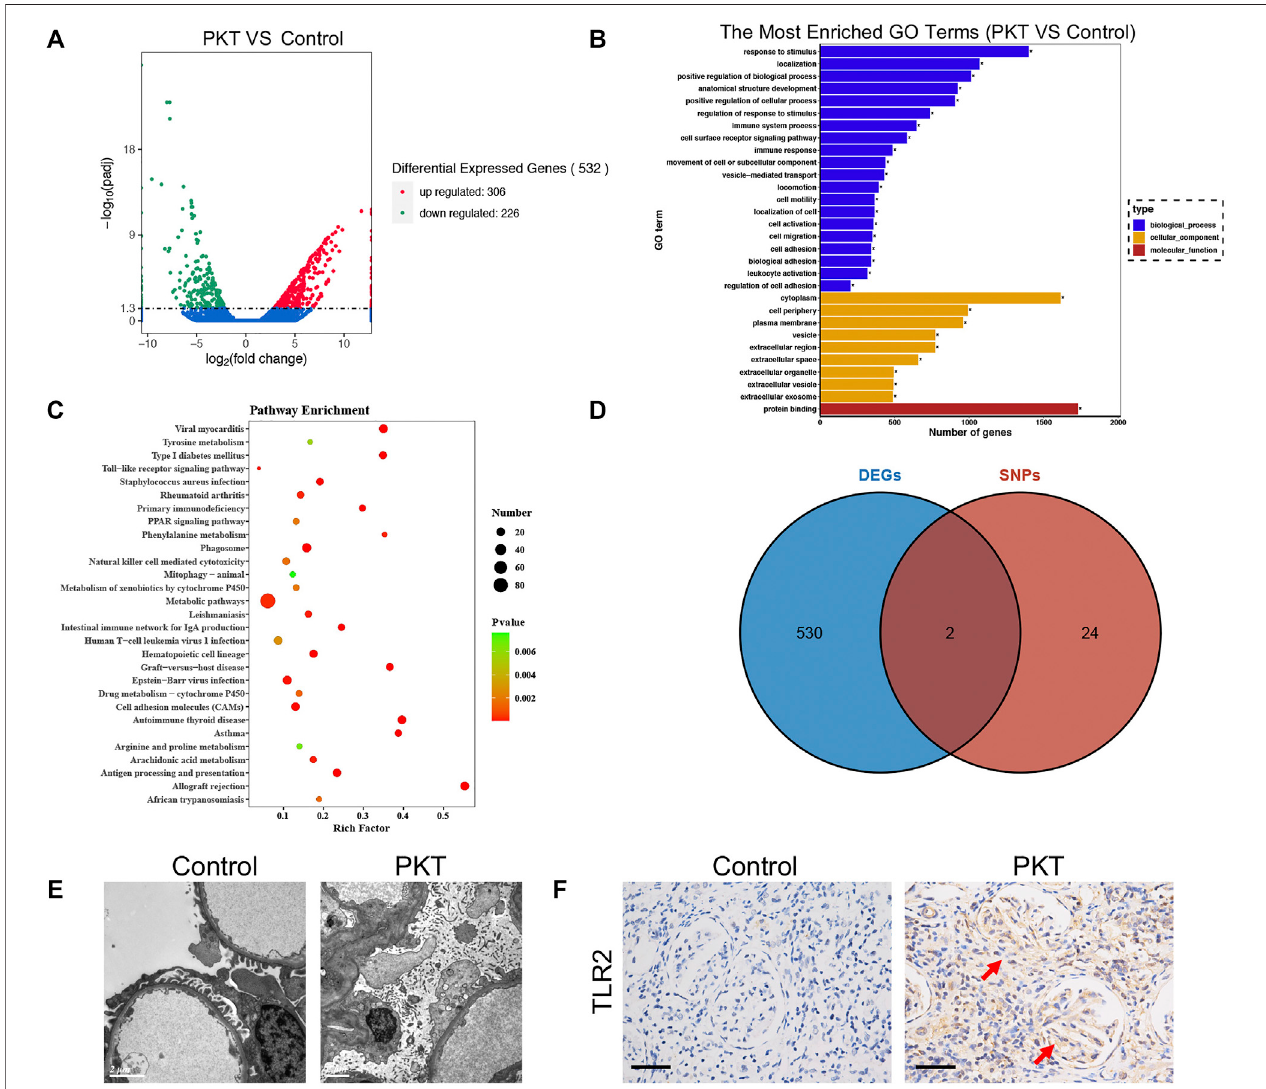
FIGURE 1 | Identi fi cation and functional annotation of DEGs and validation of TLR2 expression in tissue. (A) Volcano plots of 532 DEGs are shown between the PKT and control groups with 306 upregulated genes and 226 downregulated genes. (B) GO enrichment analysis – depicted DEGs are associated with the immune system and in fl ammatory response. (C) KEGG analysis of the DEGs showing the top 20 enriched KEGG terms including toll − like receptor signaling pathway. (D) Venn diagramexhibitingtwointersectedgenesincludingtheTLR2genebetweenDEGsandSNPmutation – relatedgenes. (E) Podocytefooteffacement inpodocytesof glomeruli is seen in the PKT group under electron microscopy compared with the control group. (F) IHC staining showing TLR2 expression is higher in the PKT group than the control group. Abbreviation: DEGs, differentially expressed genes; PKT: proteinuria after kidney transplantation; GO, Gene Ontology; KEGG: Kyoto Encyclopedia of Genes and Genomes; SNP, single-nucleotide polymorphism; IHC: